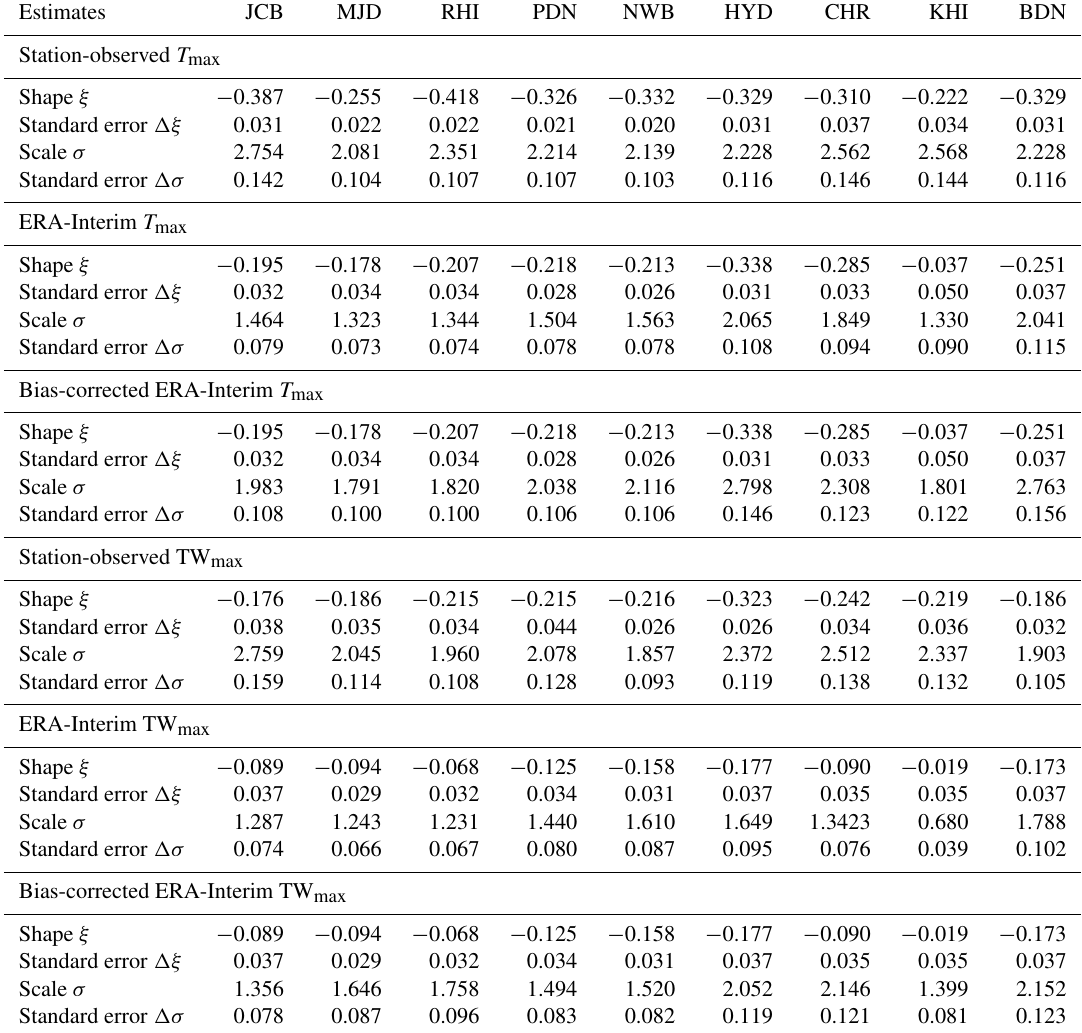
Table 3. Estimated parameters shape ξ , scale σ , and standard error (cid:49)ξ , (cid:49)σ of all the datasets.